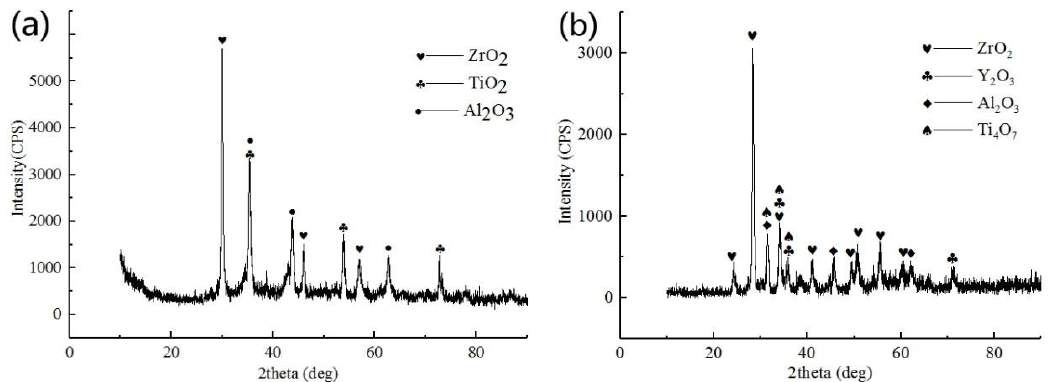
Figure 5. XRD pattern of the specimens at 750 °C for 100 h: ( a ) Zr coating; ( b ) Zr-Y coating.